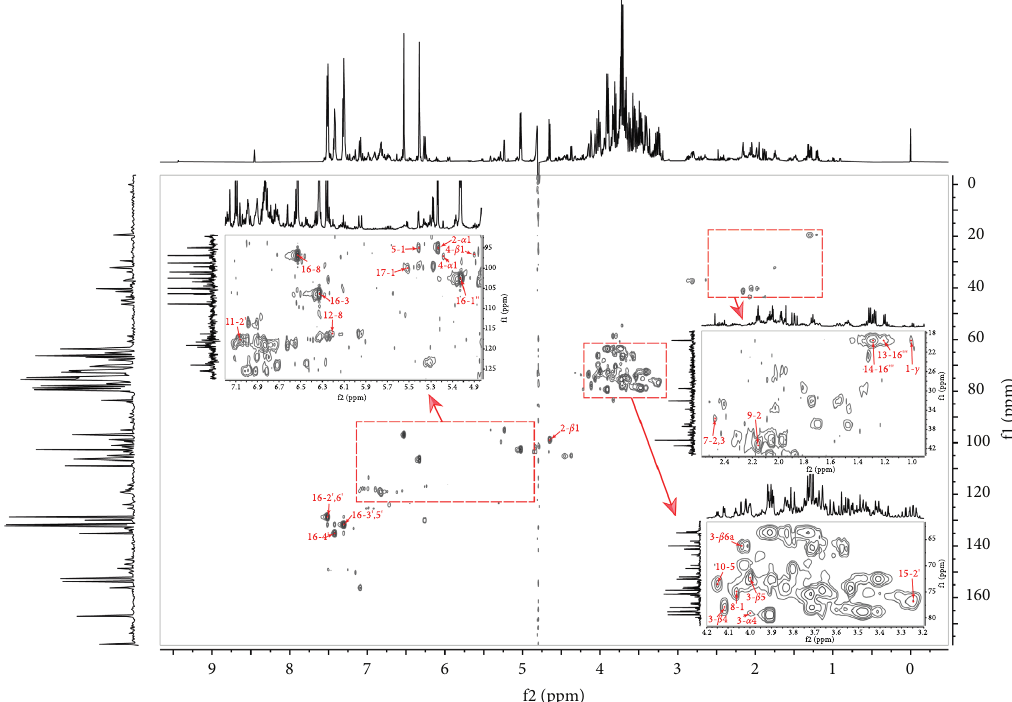
Figure 3: The key HSQC correlations of the identified components in HSQC spectrum of